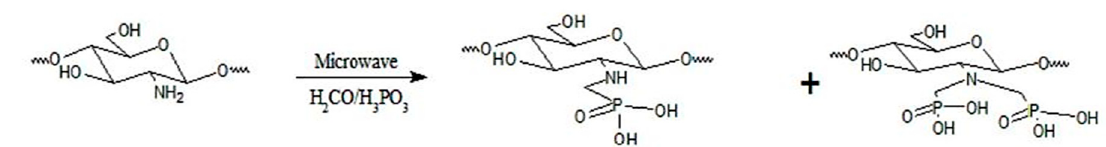
Figure11. SynthesisofN-methylenephosphonicCSviamicrowaveirradiationreaction[163]. Copyright Figure 11. Synthesis of N-methylene phosphonic CS via microwave irradiation reaction [163]. 2015, reproduced with permission from Elsevier